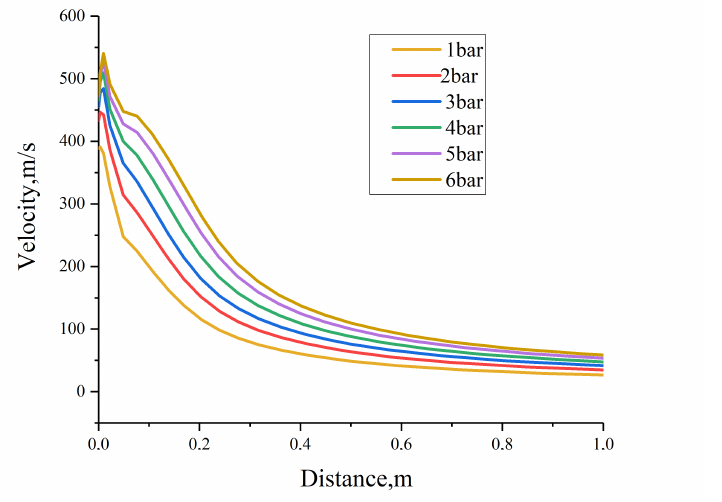
Figure 6. Change in the flow rate of the carrier gas along the central axis of the flame at pressures of 1–6 bar.